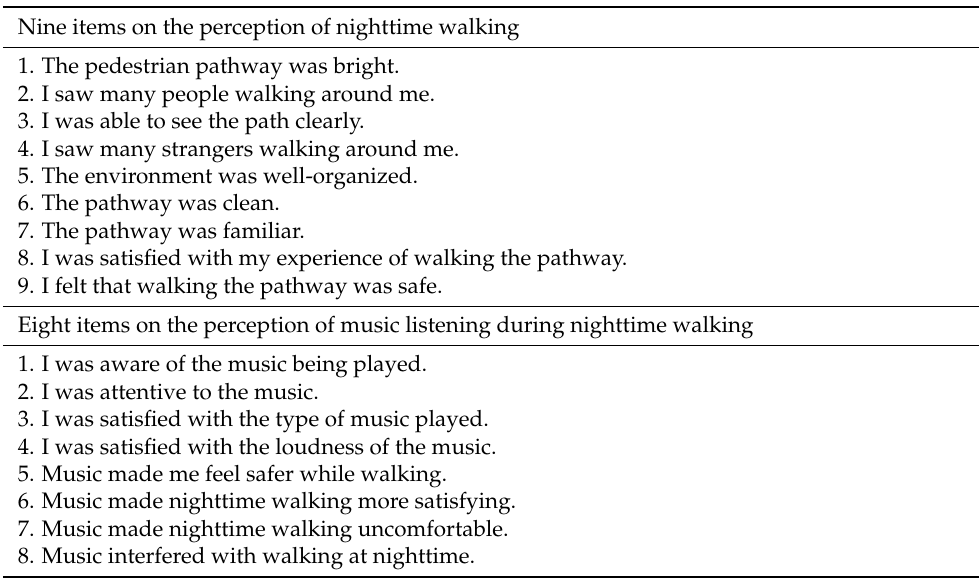
Table A1. Survey items related to the perception of nighttime walking and the perception of music listening during nighttime